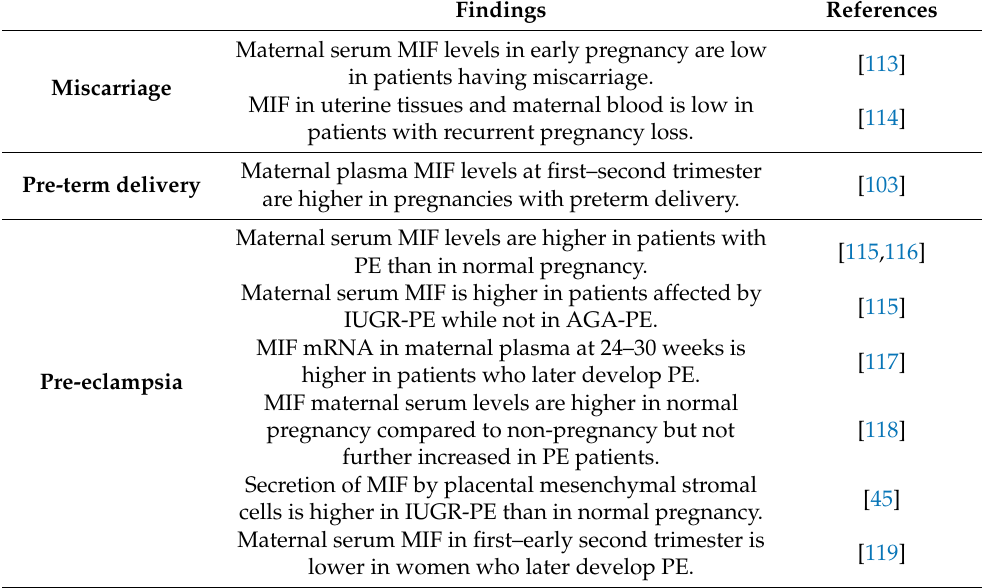
Table 2. MIF in pregnancy